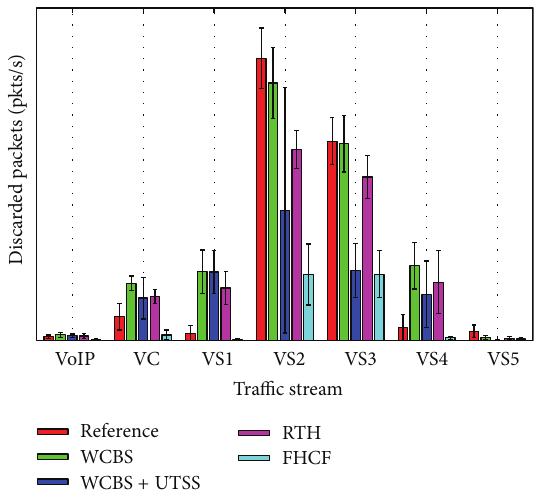
Figure 15: 99th percentile of HCCA buffer length.